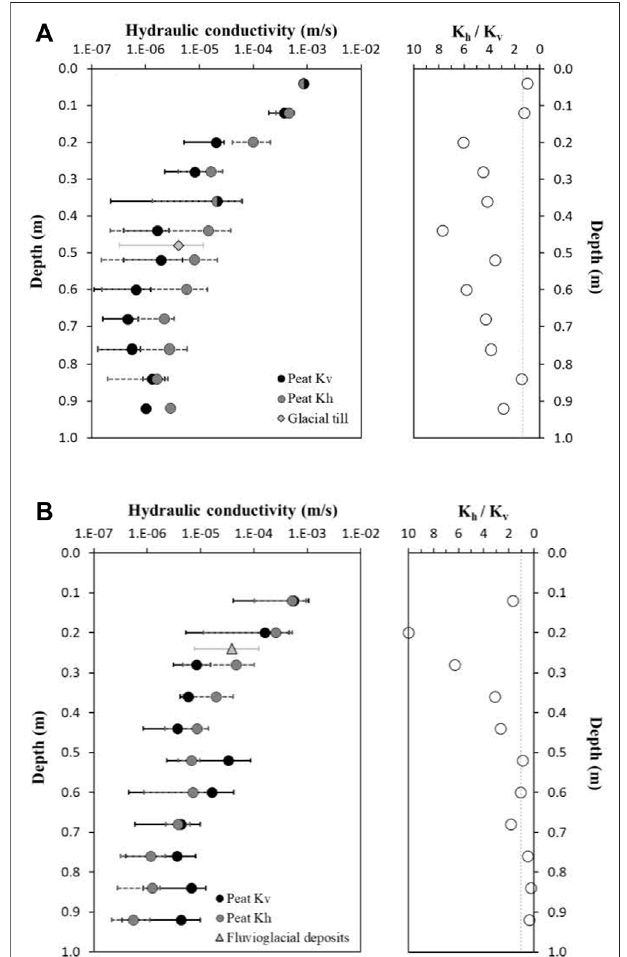
FIGURE 3 | Minimum, maximum, and average measured hydraulic conductivities of the three cores for (A) the Misask peatland and (B) the Cheinu peatland. The left panels illustrate vertical hydraulic conductivities (K v ) and horizontal hydraulic conductivities (K h ) for the peat (estimated with the MCM method) and for mineral deposits (estimated with slug tests). Panels on the right illustrate K h /K v